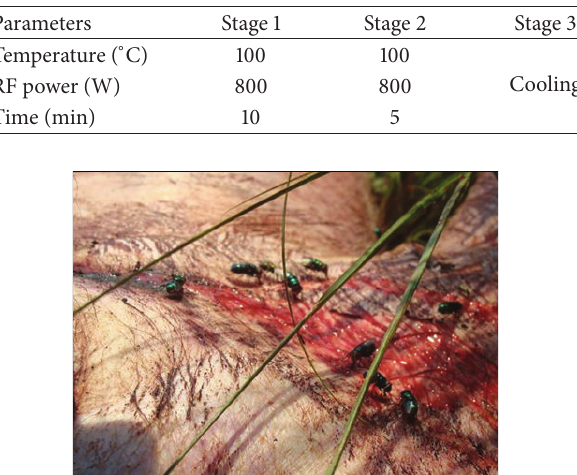
Figure 1: Adult and immature Chrysomya albiceps flies are attracted to the animal carcass in decomposition nearby the regions where the perforation by caliber .40 S&W projectiles occurred.